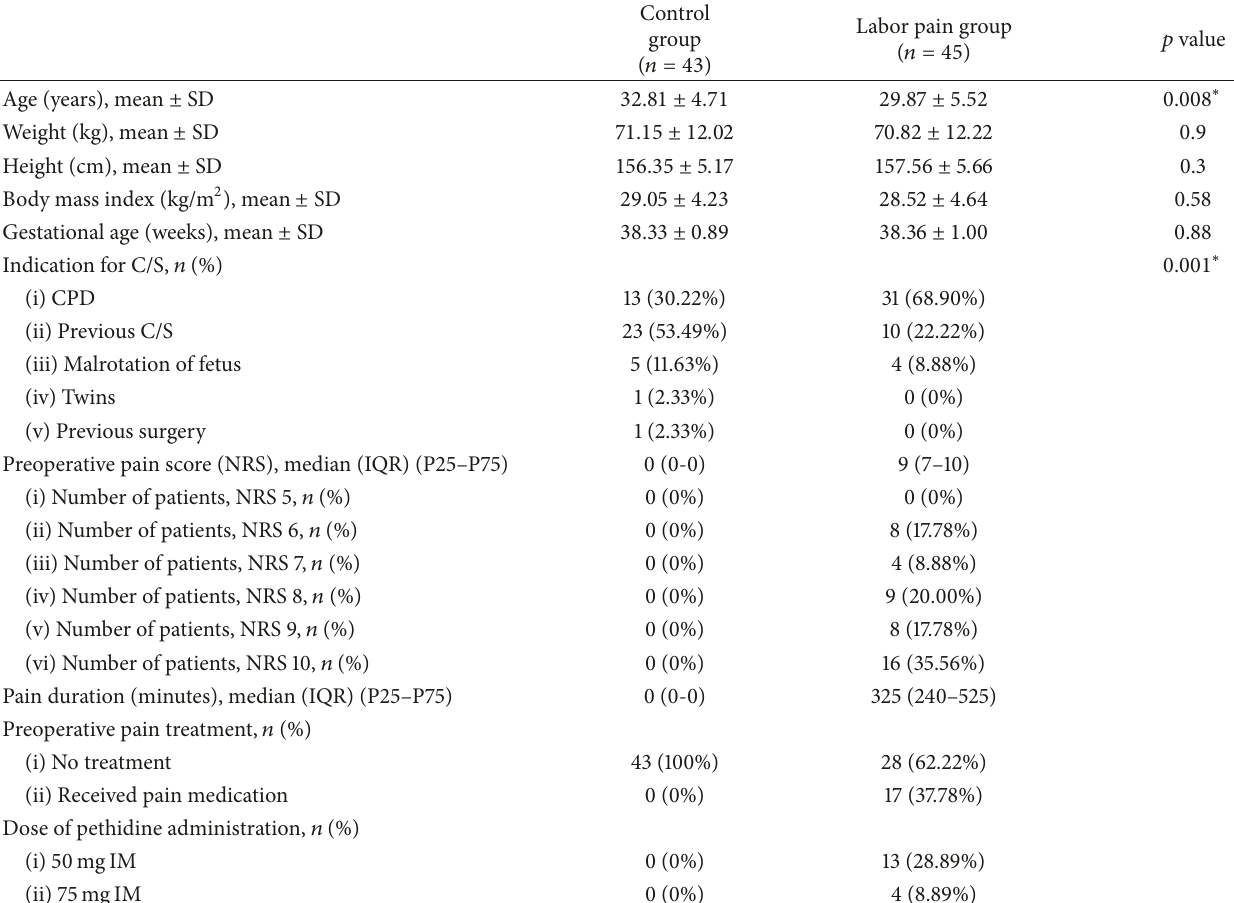
Table 1: Demographic, anthropometric, and clinical characteristics of pregnant women in the control and labor pain